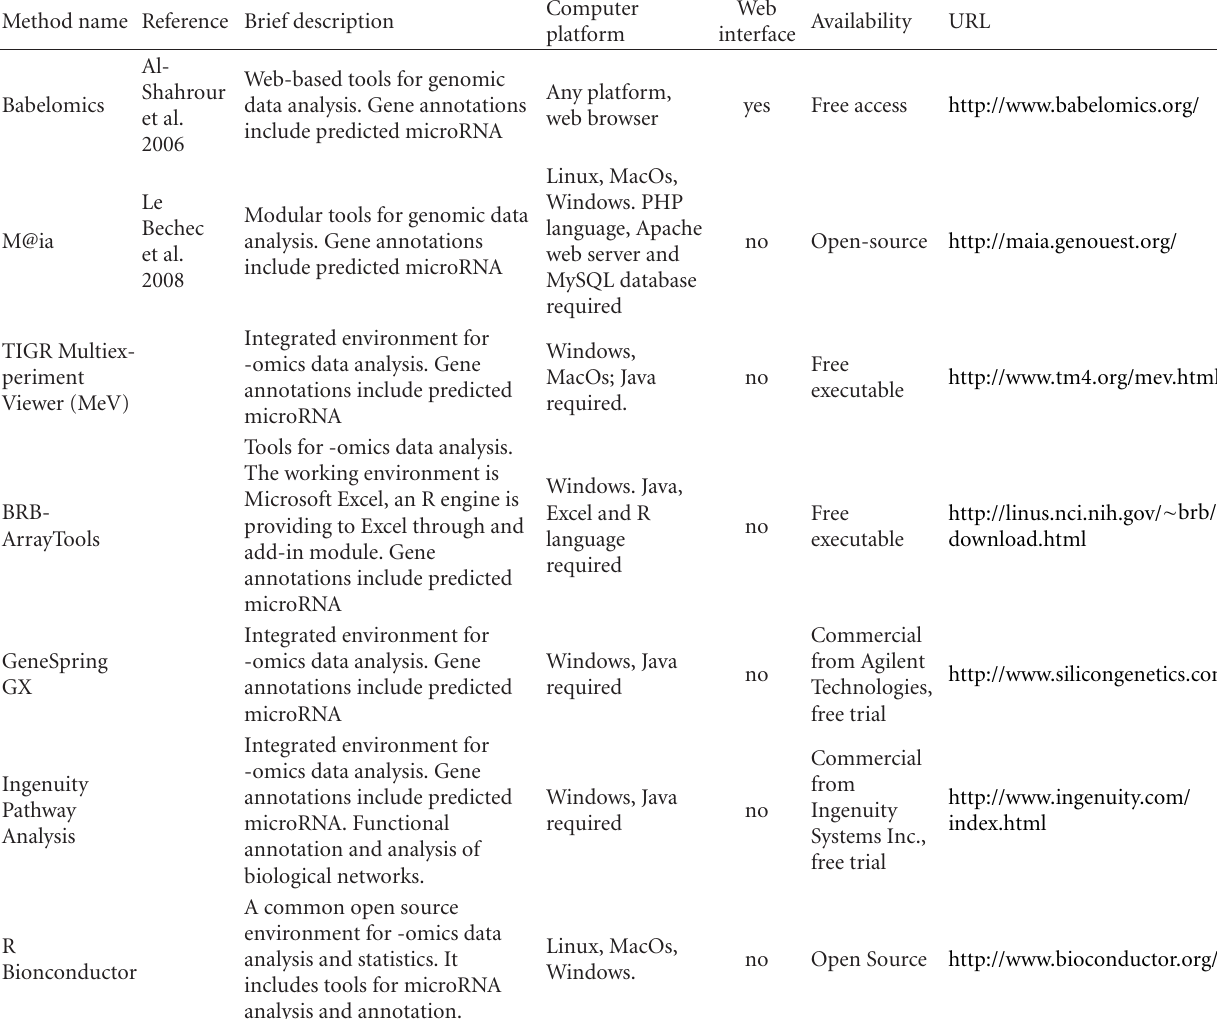
Table 1: Common softwares for “–omics” data analysis allowing in-depth analysis of high-throughput